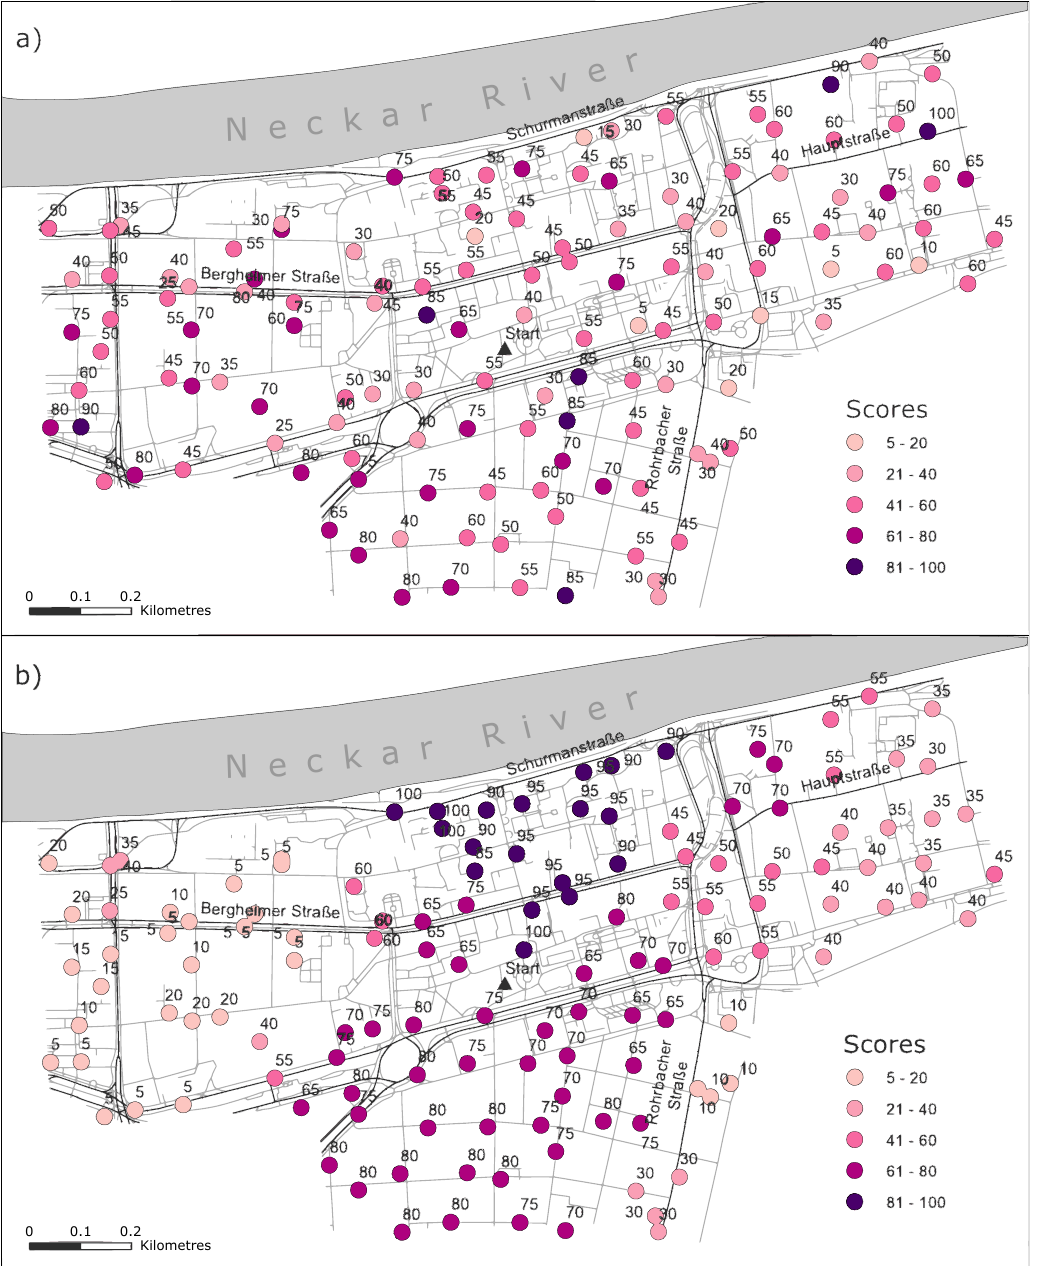
Figure 2. Overview of the two scoring systems used. ( a ) Spatially random scores; ( b ) and spatially structured scores showing a clustering